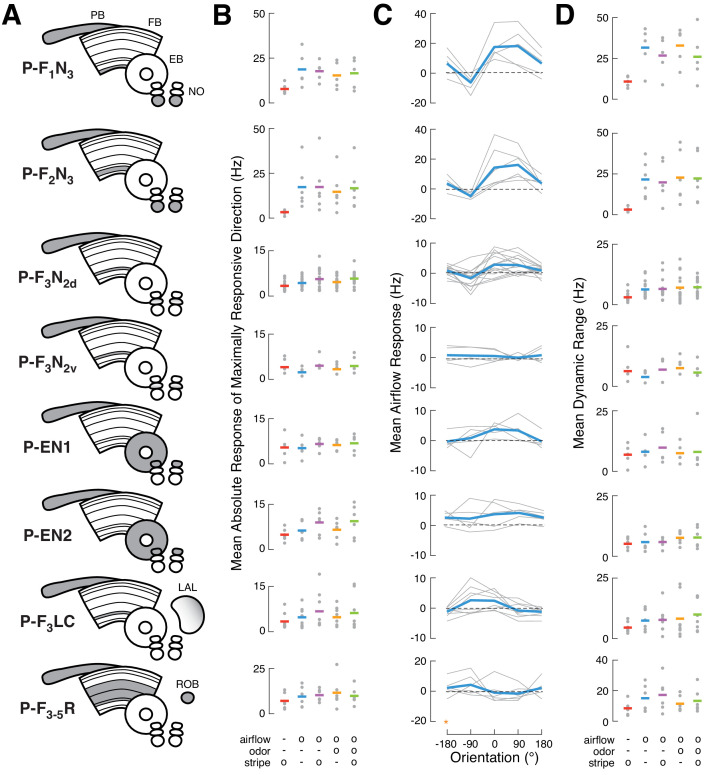
Summary of sensory responses across CX cell types.(A) CX neuropils innervated by each recorded cell type. (B) Maximal responses to each stimulus condition. Gray dots represent the mean absolute spiking response of each cell to four presentations from the direction that elicited the largest response. Horizontal bars represent the mean across cells (colors as in Figure 1B). All responses represent changes from baseline. Note different vertical scales. (C) Tuning for airflow direction. Mean spiking response as a function of airflow direction for each neuron (gray), and across neurons of a given type (blue). Note different vertical scales. Data at −180° is replotted from 180° for clarity (orange star). (D) Dynamic range for each modality/condition, equal to the difference between the most excitatory and most inhibitory responses across directions. Larger values indicate stronger tuning. Single cells and cross-cell means as in (B).